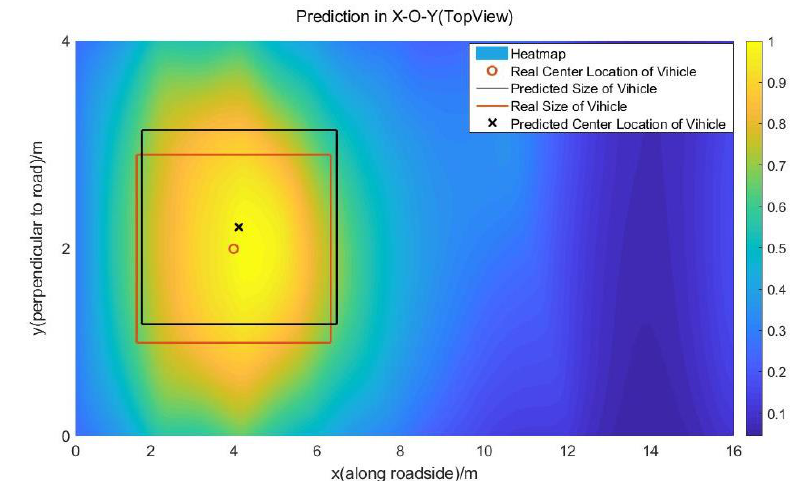
Figure 13. The heat map image of the vehicle at the location of (4 m, 2 m) in the X-O-Y plane. The central position, the length, and the width of the vehicle are predicted with a length contour threshold of 0.7 and width threshold of